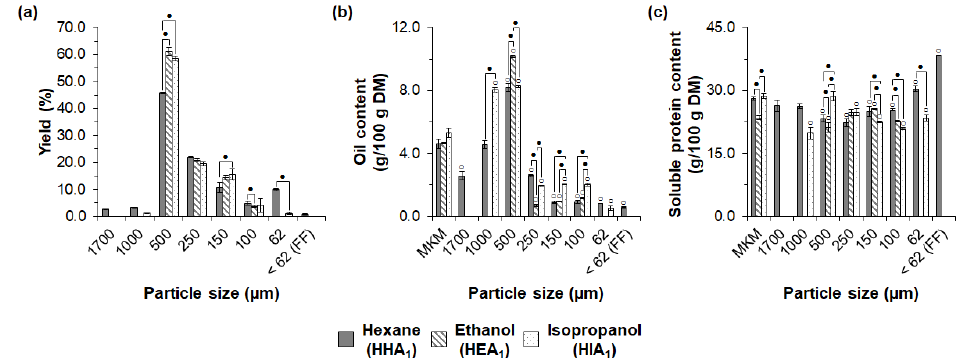
Figure 5. Influence of alternative organic solvents on exploratory sieve fractionation of macauba kernel meals from hydraulic pressing and milling to 1 mm: ( a ) yields, ( b ) oil content, and ( c ) soluble protein content of the sieved fractions. MKM: macauba kernel meal; FF: fine fraction. White circles indicate significant differences ( p < 0.05) in relation to respective MKMs. Dark circles indicate sig- nificant differences ( p < 0.05) between fractions of the same particle size and different solvent ex- traction. The use of ethanol and isopropanol jeopardized the yield of fractions with small par- ticle sizes. Deoiling with ethanol (HEA 1 ) did not produce fractions below 100 µm, and the yield of the 62 µm fraction was significantly lower after extraction with isopropanol (1.1%) compared to hexane (9.0%). In addition, deoiling with hexane (HHA 1 ) also produced a FF, which was not obtained after extraction with ethanol (HEA 1 ) or isopropanol (HIA 1 ). As shown in Figure 5b, the sieved fractions with large particle sizes showed signifi- cantly higher oil content when ethanol and isopropanol were used for oil extraction. The 1000 µm fraction showed oil content of 4.6 and 8.1% after extraction with hexane (HHA 1 ) and isopropanol (HIA 1 ), respectively. The oil content of the 500 µm fraction was signifi- cantly higher for extraction with ethanol (10.3%) than with hexane (8.2%). The lower effi- ciency of ethanol and isopropanol in deoiling coarser fractions might relate to their lower miscibility with oil [18,78] and diffusive constraints of the solvent miscella in the solid matrix and bulk solution [76]. The soluble protein content of the sieved fractions was also influenced by the type of solvent used for oil extraction (Figure 5c). As previously discussed, the FF from hexane extraction (HHA 1 ) showed an increased soluble protein content (38.4 g/100 g DM), indi- cating a higher functionality and protein enrichment. After deoiling with ethanol (HEA 1 ), the 150 µm fraction showed a slight significant increase in the soluble protein content (from 23.5 to 25.6 g/100 g DM) compared to the HEA 1 . When the press cake was extracted with isopropanol (HIA 1 ), no fraction showed an increased soluble protein content com- pared to the input material HIA 1 . The lower sieve fractionation performance after extraction with ethanol and isopro- panol might have been attributed to their denaturing effect, as evidenced by the lower MKM protein functionality, as discussed in Section 3.1. To the best of our knowledge, no studies focusing on the influence of alternative organic solvents in the dry fractionation of oilseed proteins are available. Nevertheless, our results suggested that the solvent em- ployed for deoiling can modify the milling behavior, distribution of nutrients, and func- tionality of the fractions during dry processing. Therefore, in our study, hexane was the preferred solvent for oil extraction, aiming the dry recovery of macauba kernel proteins. In addition, future research might need to focus on finding out the extraction conditions based on alcohols that largely prevent protein denaturation and improve the dry fraction- ation of deoiled meals. The determination of meal morphology, the integrity of protein